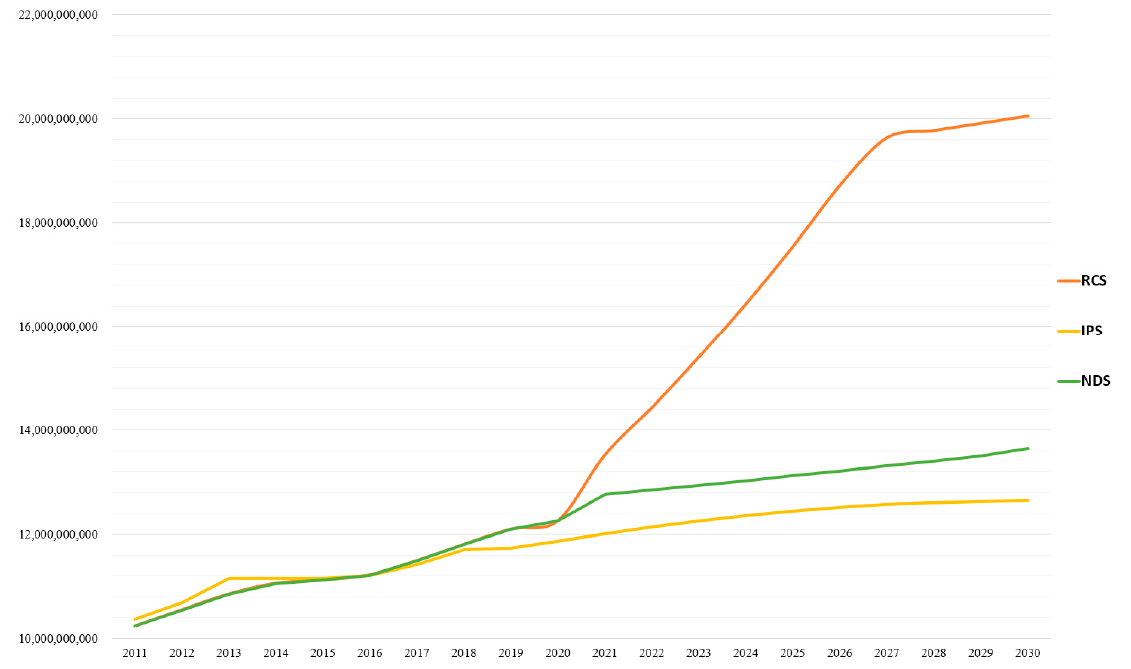
Figure 1. Carbon emission projections for the three scenarios.